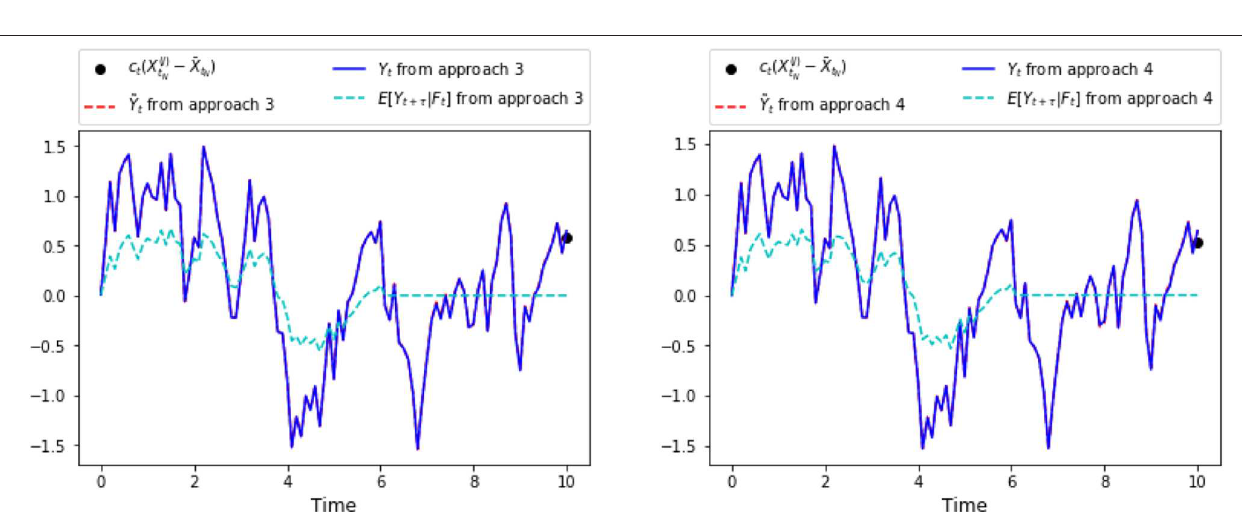
FIGURE 5 | Plots of representative trajectories of [( Y t